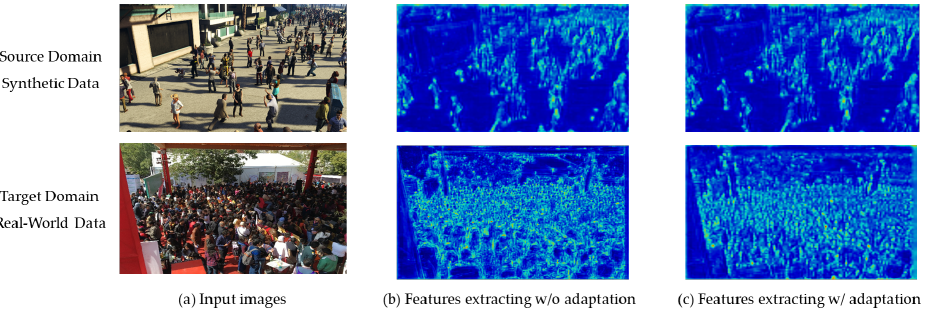
Figure 4. The comparison of feature extraction between the source and target domains. ( a ) shows the input images, ( b ) shows the feature extraction results without adaptation, and ( c ) shows the feature extraction results with adaptation. When using real-world images for testing, we compared the results in ( b , c ). Generated feature maps with adaptation will have less noise than those without adaptation.